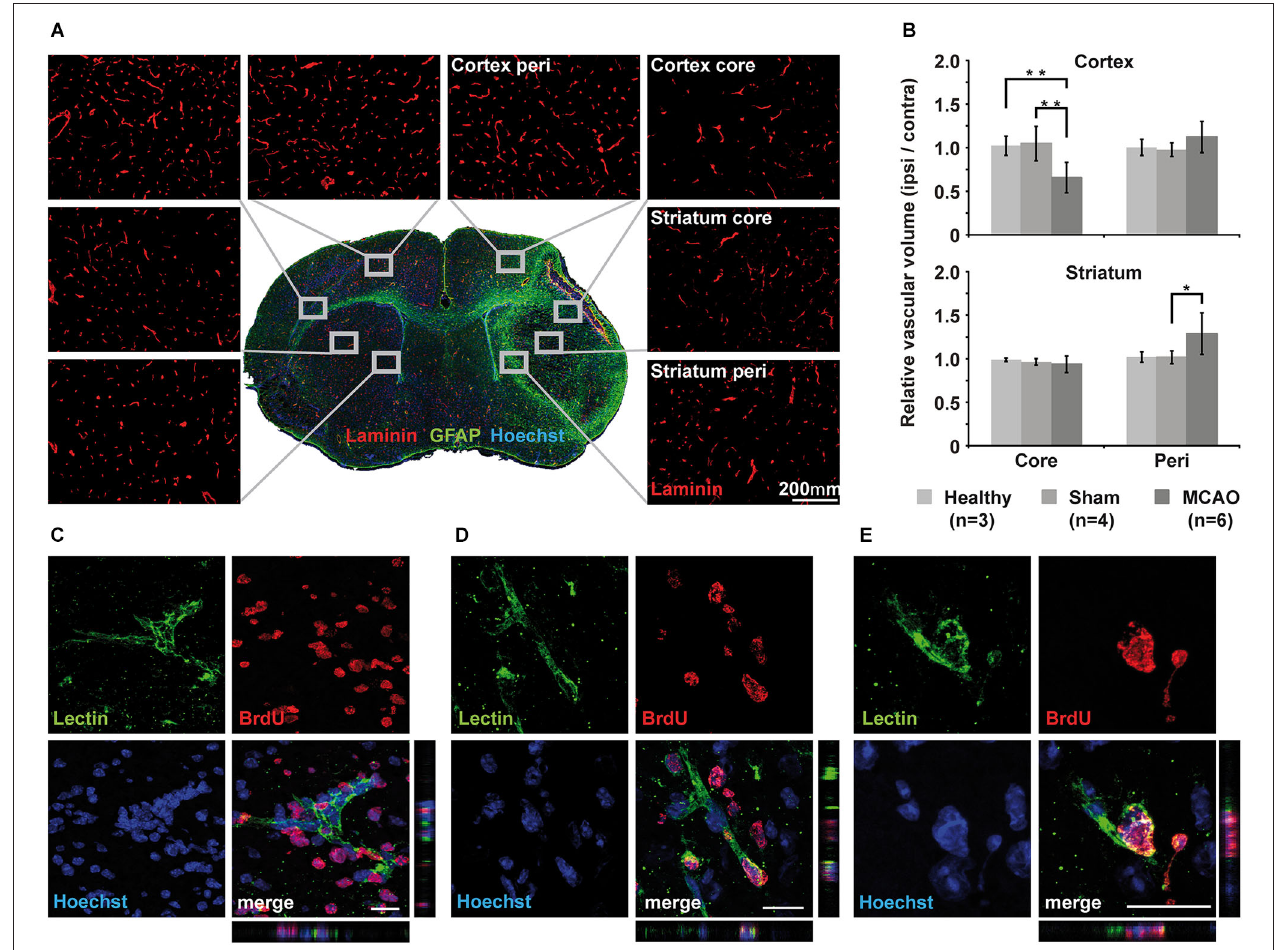
Vascular volume increases significantly in the striatal peri-infarct zone ( p = 0.03) but does not reach significance in peri-infarct cortex ( p = 0.08). Sham animals showed little changes in corresponding areas of the brain. (C–E) Three examples of Z-stacks of representative BrdU+/lectin+newly formed endothelial cells from the peri-infarct striatum (C) and the cortex (D,E) . Scale bar 20 µ